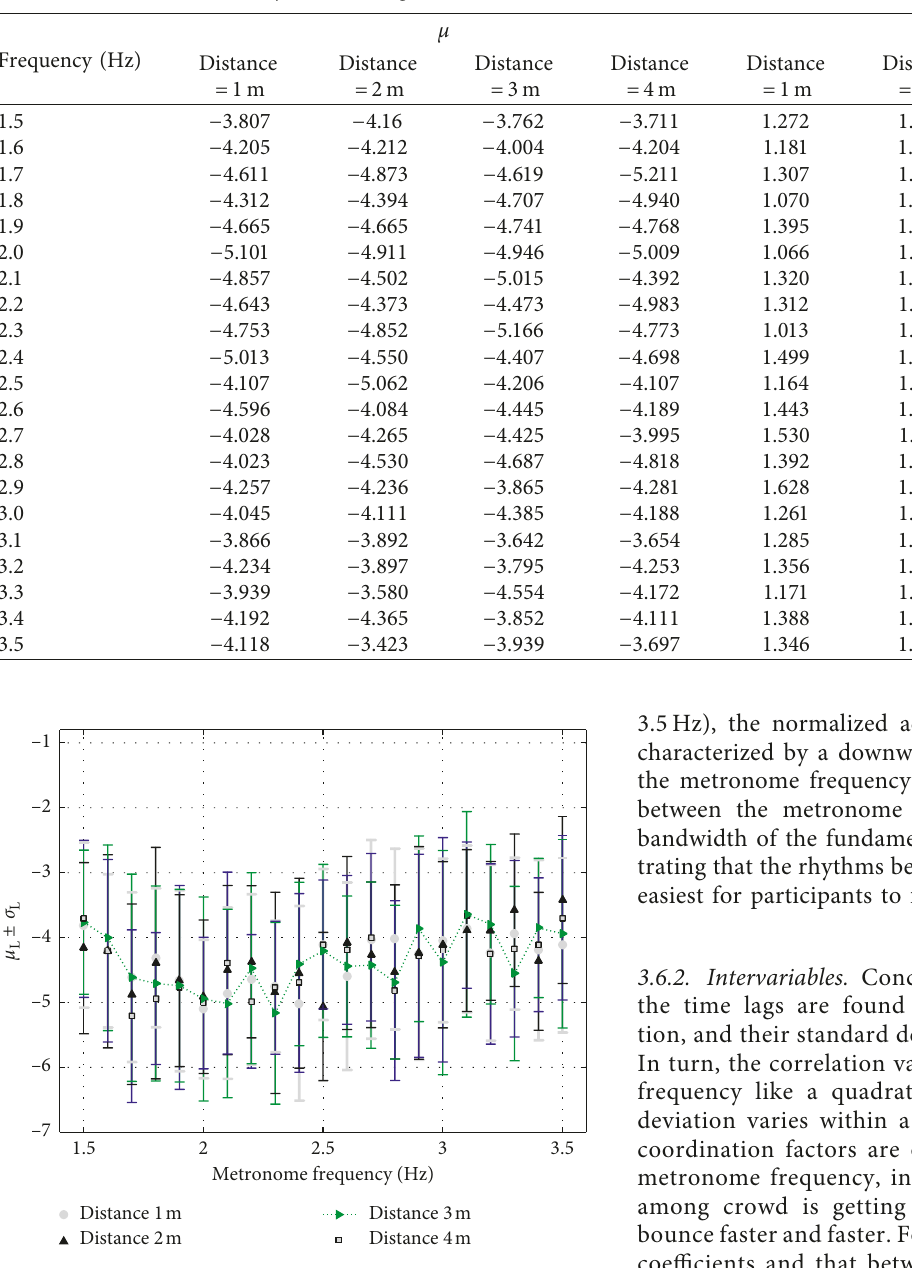
Figure 20: Error bar of lognormal distribution parameters of coherence coefficients in the lateral